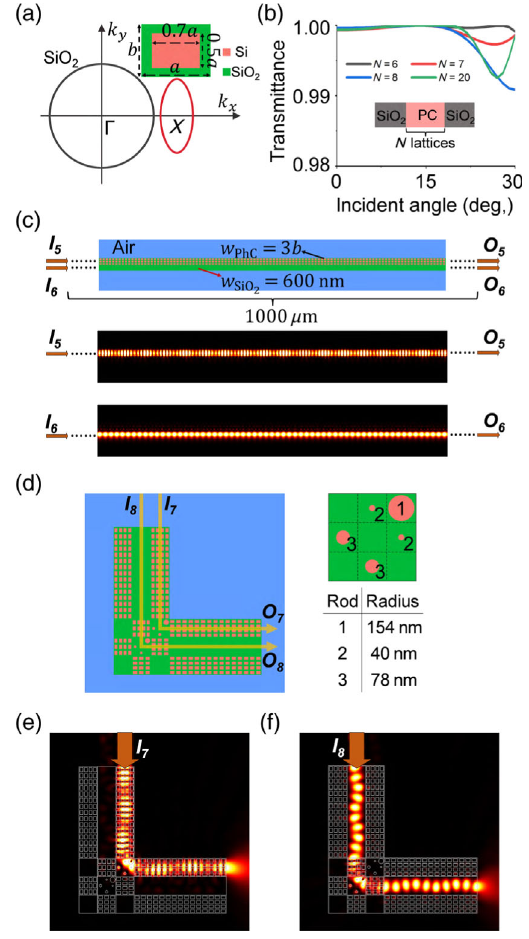
FIG. 6. Optical design of the ultracompact photonic circuits. (a) The unit cell and EFC of the PC. The lattice constant a ¼ 370 nm and b ¼ 0 . 75 a . (b) The transmittance of the PC in silica with 6, 7, 8, and 20 layers. (c) The propagation of PC ( I 5 - O 5 ) and silica channels ( I 6 - O 6 ) with 1000 μ m ( 2703 a ) propagating dis- ¼ 3 b ¼ tance. The width of the PC (silica) channel is w PC 832 . 5 nm ( w ¼ 600 nm). (d) The schematic diagram of the SiO 2 PC ( I 7 - O 7 ) and silica channels ( I 8 - O 8 ) without any cladding between them. The right panels are the enlarged view of the corner supercells, and the table shows the radii of silicon rods. (e),(f) The simulated intensity distribution under independent excitation from the input ports I i ( i ¼ 7 , 8). The bending losses are − 0 . 10 dB for the PC channel and − 0 . 07 dB for the silica